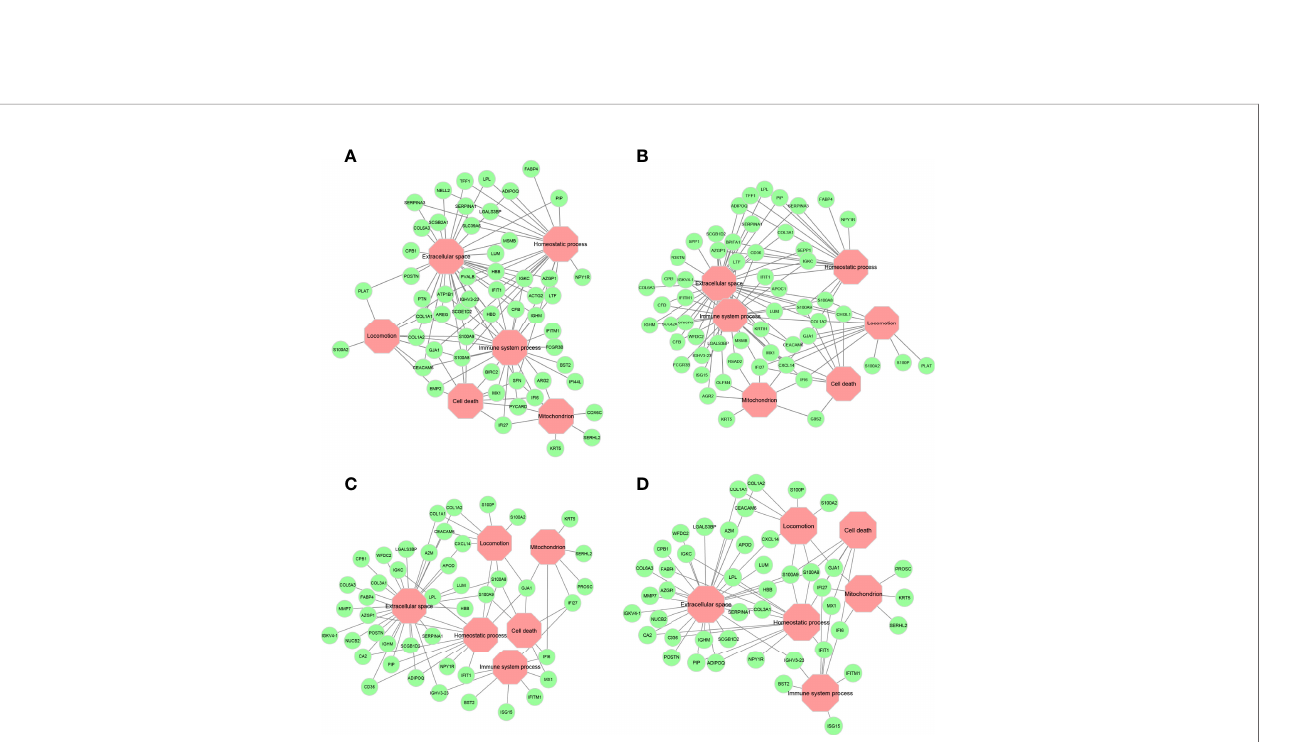
FIGURE 7 | Major gene ontology (GO) terms for ANNE decoded networks. (A) Good prognosis. (B) Poor prognosis. (C) Chemosensitive (pCR). (D) Chemoresistant (RD). Octagonal nodes (pink) represent GO processes. Circular nodes (green) are genes detected in encoded networks derived from top 200 gene pairs with the largest absolute association